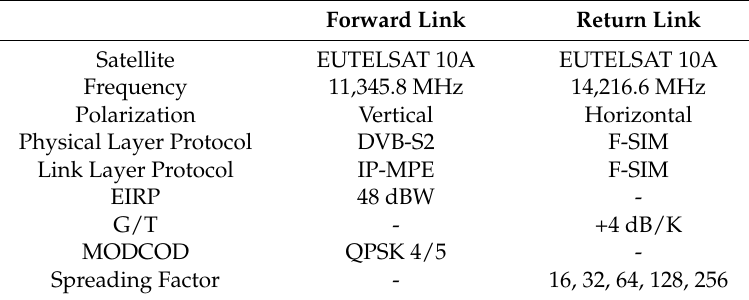
Table 1. NEFOCAST Space